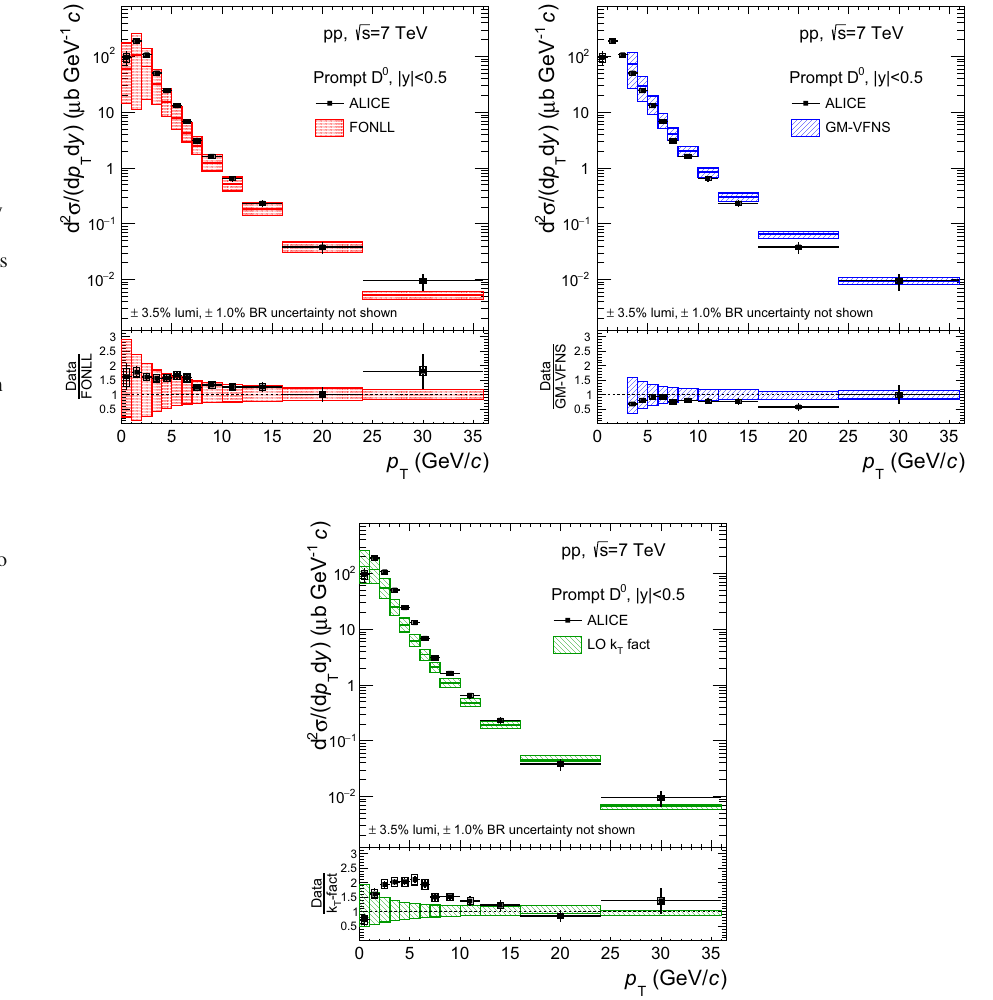
The ratios of D 0 -meson production cross sections in dif- ferent rapidity intervals, which are expected to be sensitive to the gluon PDF at small values of Bjorken- x [22], were com- puted from our measurement in the central rapidity region ( | y | < 0 . 5) and the results reported by the LHCb collab- √ s = 7 TeV in different y oration for pp collisions at intervals at forward rapidity [19]. The results are reported in Fig. 9, where the central-to-forward ratios are shown as a function of p T for three different y intervals at forward rapidity: 2 < y < 2 . 5 (left panel), 3 < y < 3 . 5 (middle panel), 4 < y < 4 . 5 (right panel). The error bars represent the total uncertainty obtained from the propagation of the statistical and systematic uncertainties on the p T -differential cross sections. The measured ratios are compared to FONLL calculations,shownasboxesinFig.9.Thecentral-to-forward ratios computed using the central values of the factorisation and renormalisation scales are found to describe the data within their uncertainties. The upper edge of the FONLL uncertainty band, which is also in agreement with the